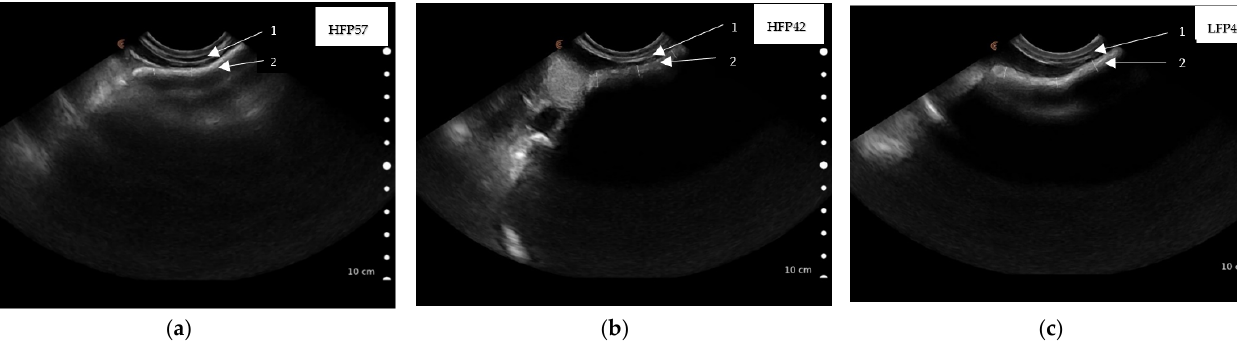
Figure 3. Ultrasound scanned images showing rumen wall thickness captured caudal to the last rib by placing the Clarius ultrasound scanner (3.0–7.0 MHz) parallel to the last ribs of seven-week (49 ± 1.2 d)-old lambs (( a ) HFP57, high fibre concentrate pellet and milk feeding to 57 d of age; ( b ) HFP42, high fibre concentrate pellet and weaning at 42 d of age; ( c ) LFP42, low fibre concentrate pellet and weaning at 42 d of age) lying on its right side, 1. Abdominal wall, 2. Rumen